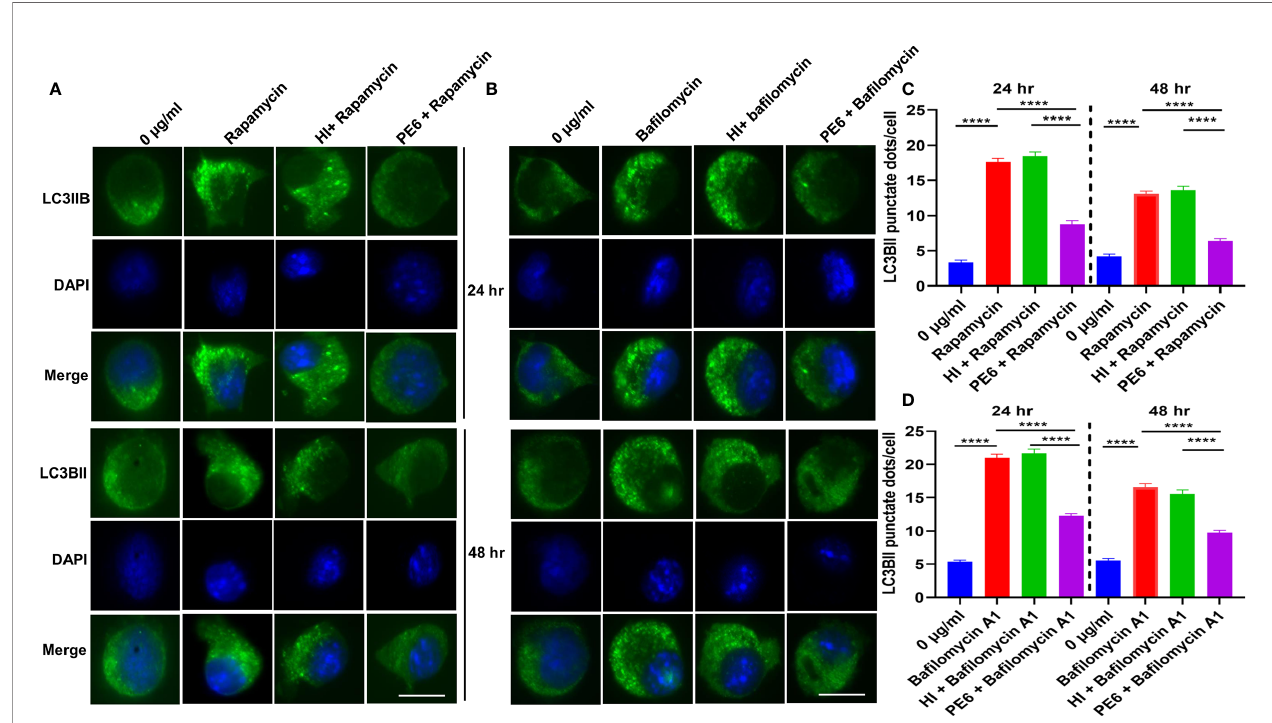
FIGURE 9 | PE6 inhibits the formation of LC3BII punctate foci in treated RAW264.7 macrophage cells in the presence of pharmacological agents rapamycin and ba fi lomycin A1. (A) Analysis of immuno fl uorescence microscopic images showing the LC3BII foci in untreated, rapamycin (200 nM) treated, HI + rapamycin-treated, and PE6 + rapamycin-treated RAW264.7 cells at 24 and 48 h. DAPI was used to mark the nucleus. Untreated and rapamycin-treated cells were used as negative and positive controls, respectively. (B) Immuno fl uorescence microscopic images demonstrating the LC3BII foci in untreated, HI treated, and PE6 treated RAW264.7 cells in the presence of ba fi lomycin A1 (50 nM). Untreated and ba fi lomycin A1 treated cells were used as negative and positive controls. (C, D) The average number of LC3BII punctate foci were counted using Axio-vision software and represented as a bar graph. Scale bars indicate 10 µM. Data were analyzed using paired T-test with the Kruskal – Wallis post-test. Data are representative of three independent experiments. ****P < 0.001 vs .